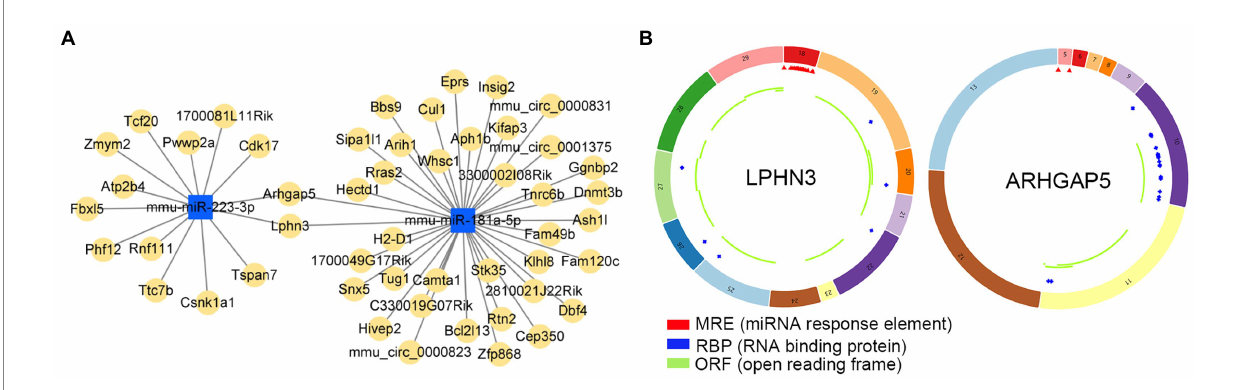
FIGURE 9 The analysis of circRNA-miRNA networks. (A) The competing endogenous RNA networks of DEmiRNAs. (B) Structural patterns of circLPHN3 and circARHGAP5. The colored circle represents the circRNAs that consist of exons. The numbers on the circRNAs mean the exon number. The red,blue, and green regions inside the circRNA molecule, respectively represent MRE (microRNA response element), RBP (RNA binding protein), and ORF (open reading frame).